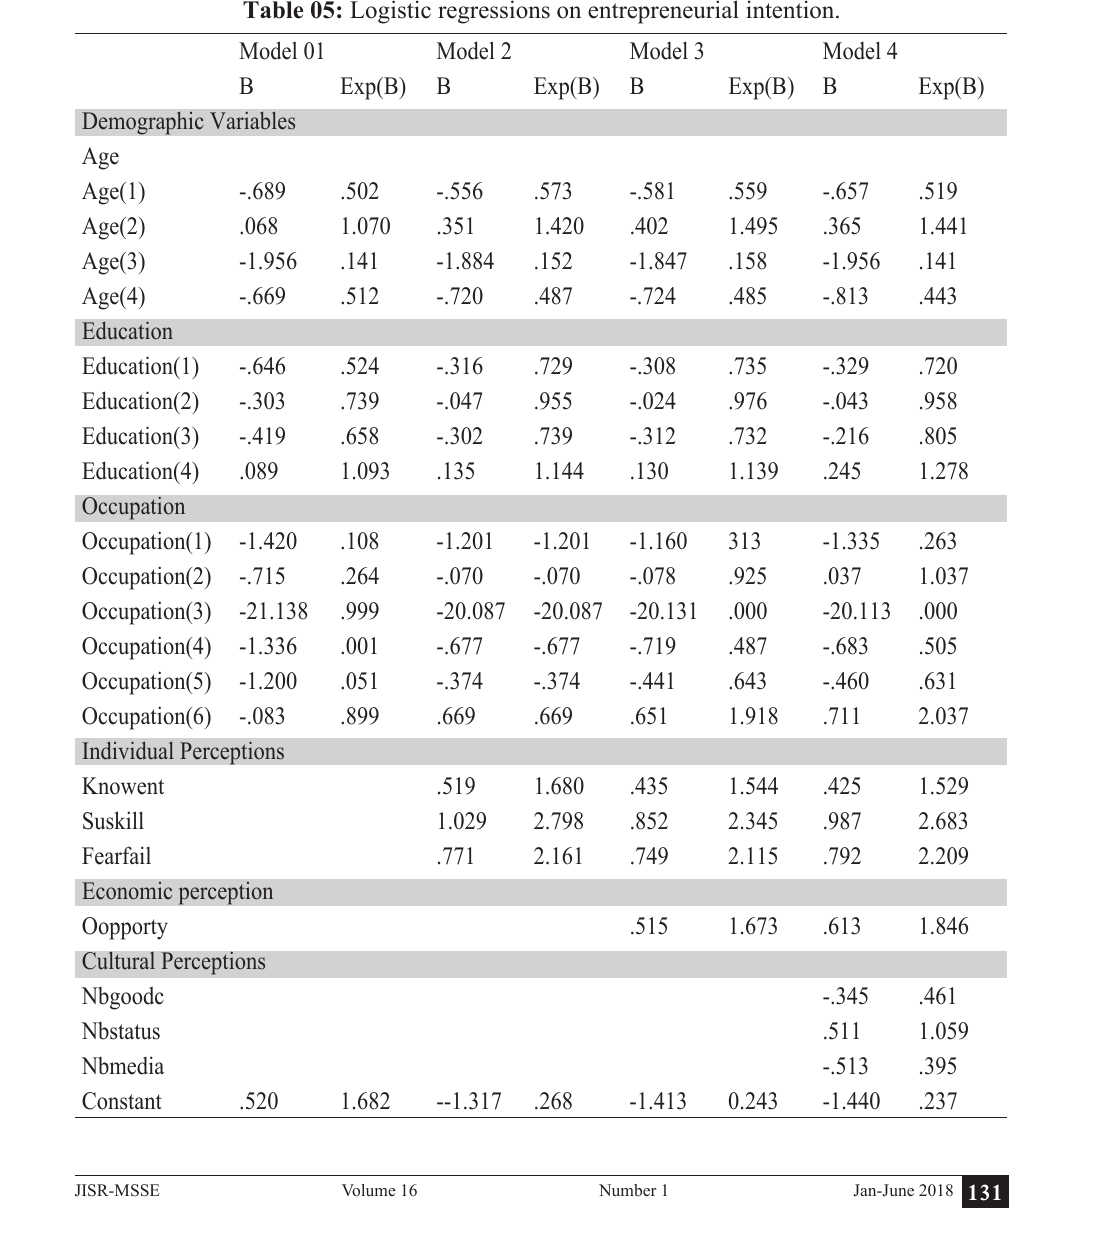
Table 05: Logistic regressions on entrepreneurial